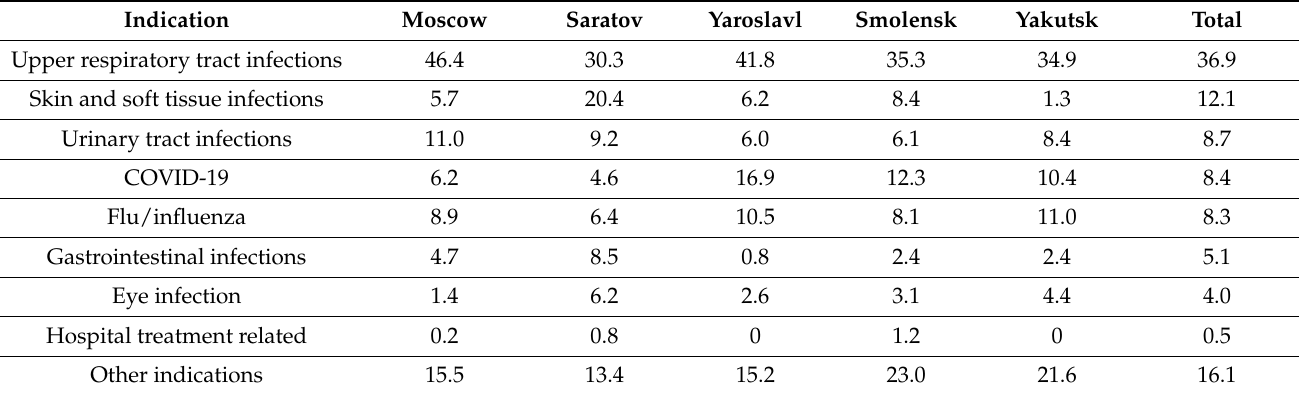
Table 6. Recorded indications for AM supplied in community pharmacies,